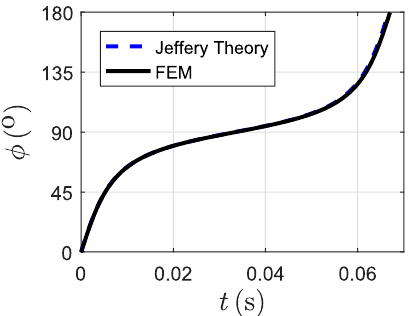
Figure 3. Comparison between the finite element method (FEM) simulation and Jeffery’s theory on particle rotation.